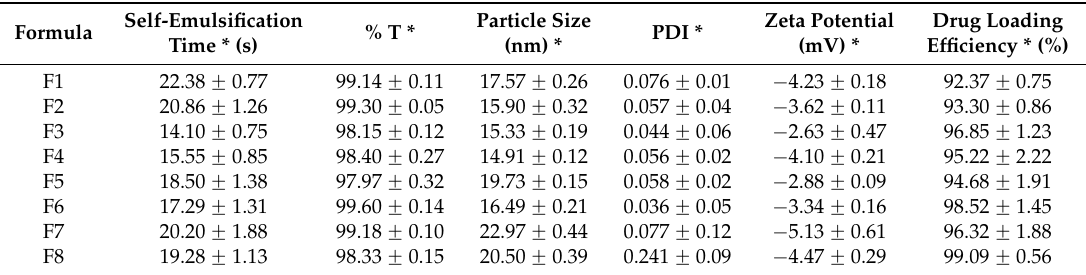
Table 7. Self-Emulsification Time, % Transmittance, Particle Size, PDI, Zeta Potential and Drug Loading Efficiency of OLM SNEDDS